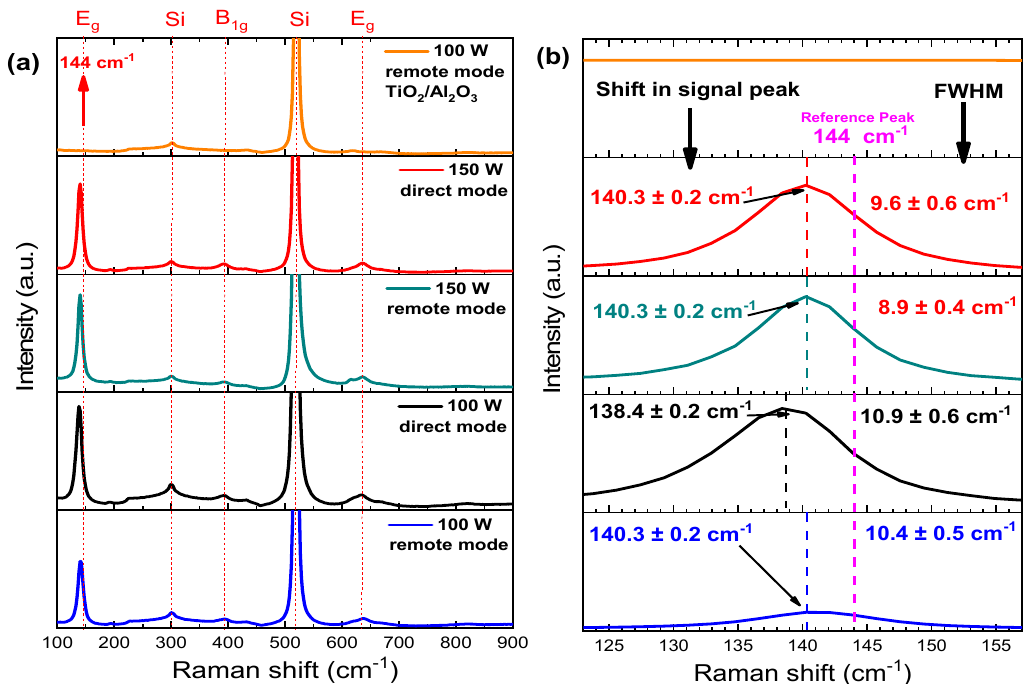
Figure 4. ( a ) Micro-Raman spectra for TiO 2 films deposited under different conditions of RF power, plasma mode and Al 2 O 3 partial-monolayer insertion and ( b ) micro-Raman spectra evidencing the shift and the FWHM of the E g peak at 144 cm − 1 .